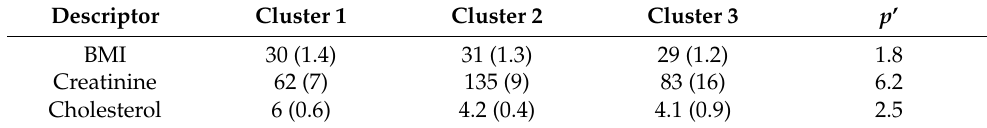
Table 3. Variables of the best k-means clustering for ischemic heart disease underlying disease.